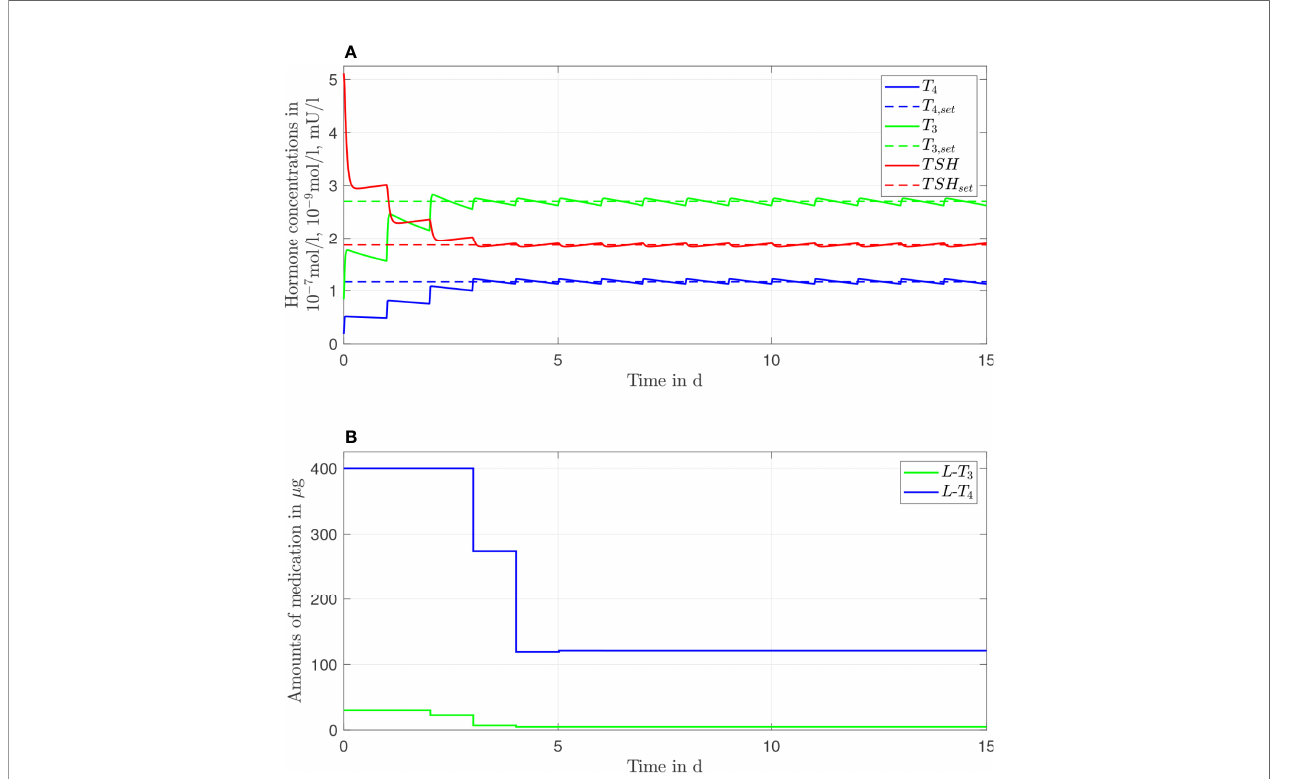
FIGURE 3 | Simulation results of an L-T 3 /L-T 4 combined therapy for a generic hypothyroid patient. The hormone concentrations (A) result from the application of the thyroid hormone replacement dosages (B) , which are determined by means of an